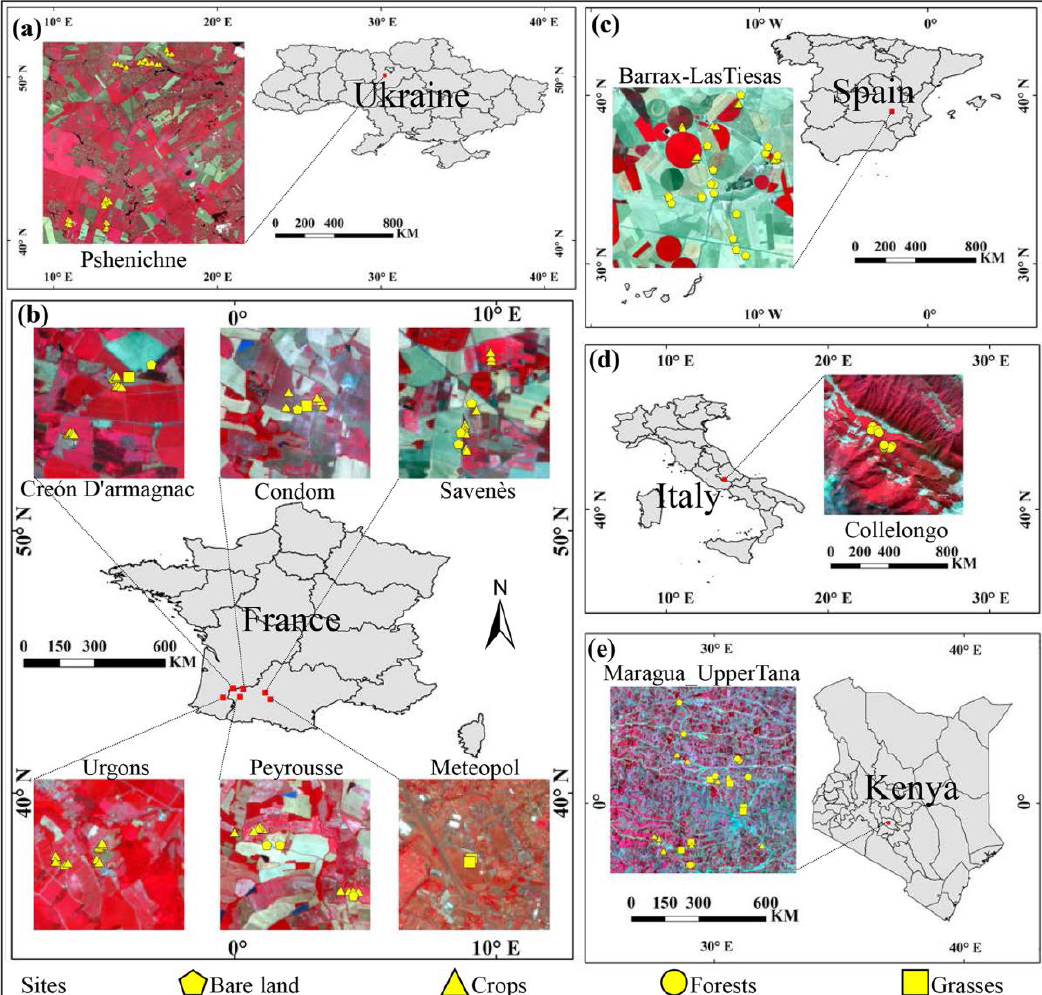
Figure 1. Spatial distribution of the selected sites for which LAI (LAI e ), FAPAR, and FVC measurements were available from 2015 to 2016. The color image (RGB) is a composition of Sentinel-2 three bands, i.e., band 8a (near-infrared), band 4 (red), and band 3 (green), at 20-m spatial resolution, where yellow points represent the ground elementary sampling units (ESUs). (a-e) denote the location of ground measurements in Ukraine, France, Spain, Italy, and Kenya, respectively.